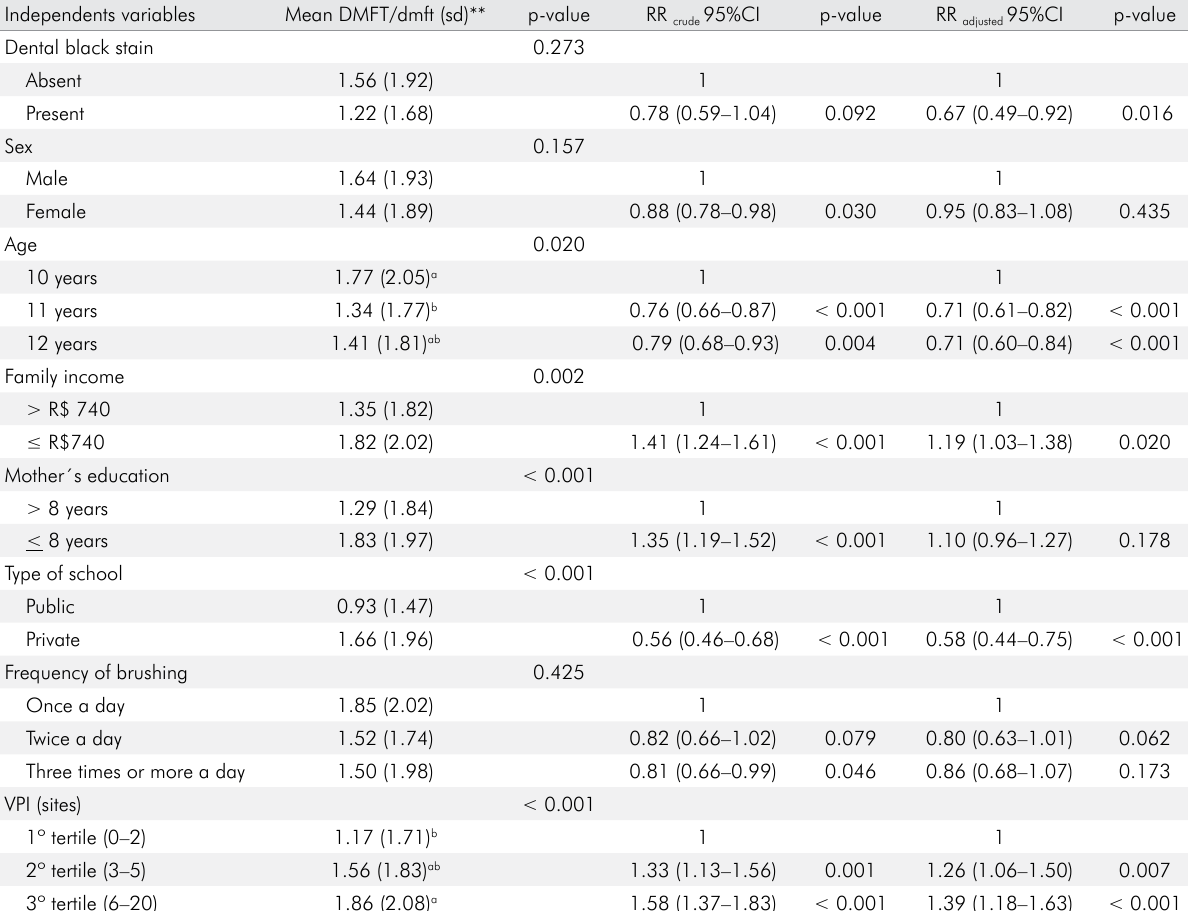
Table 3. Association between dental caries experience (DMFT/dmft) and dental black stain in schoolchildren 10–12 years. Bivariate and Poisson regression analysis. Pelotas, 2010 (n =